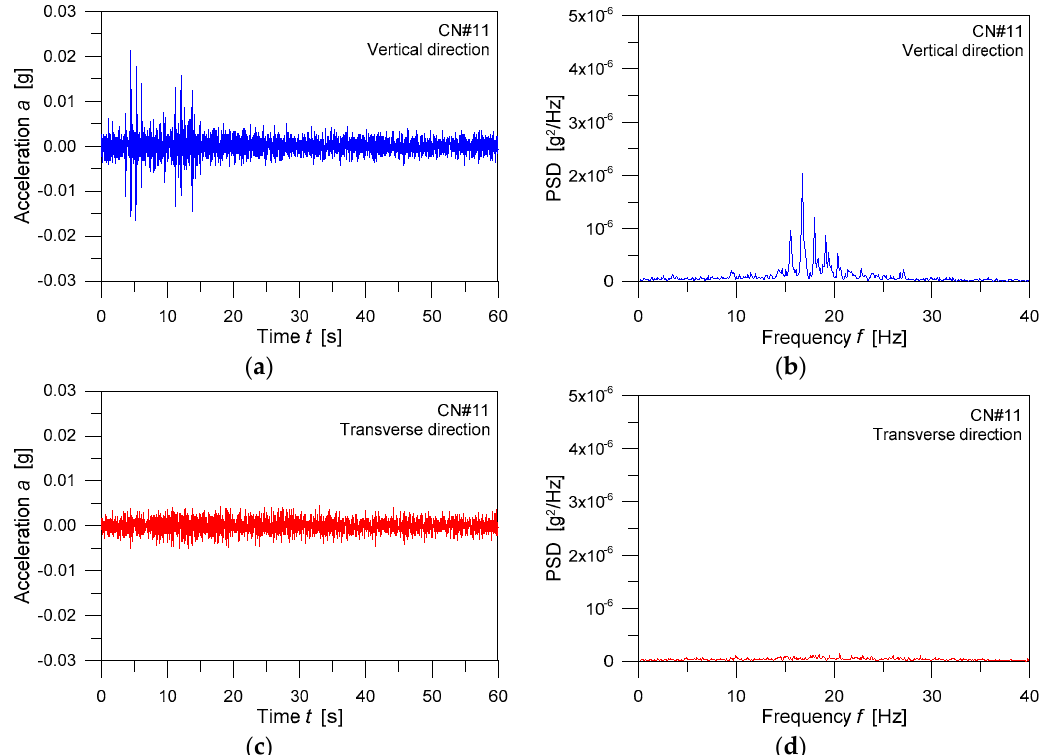
Figure 8. Examples of vibration measurements. ( a , c ) Acceleration-time history and ( b , d ) power spectral density functions under random walking traffic.